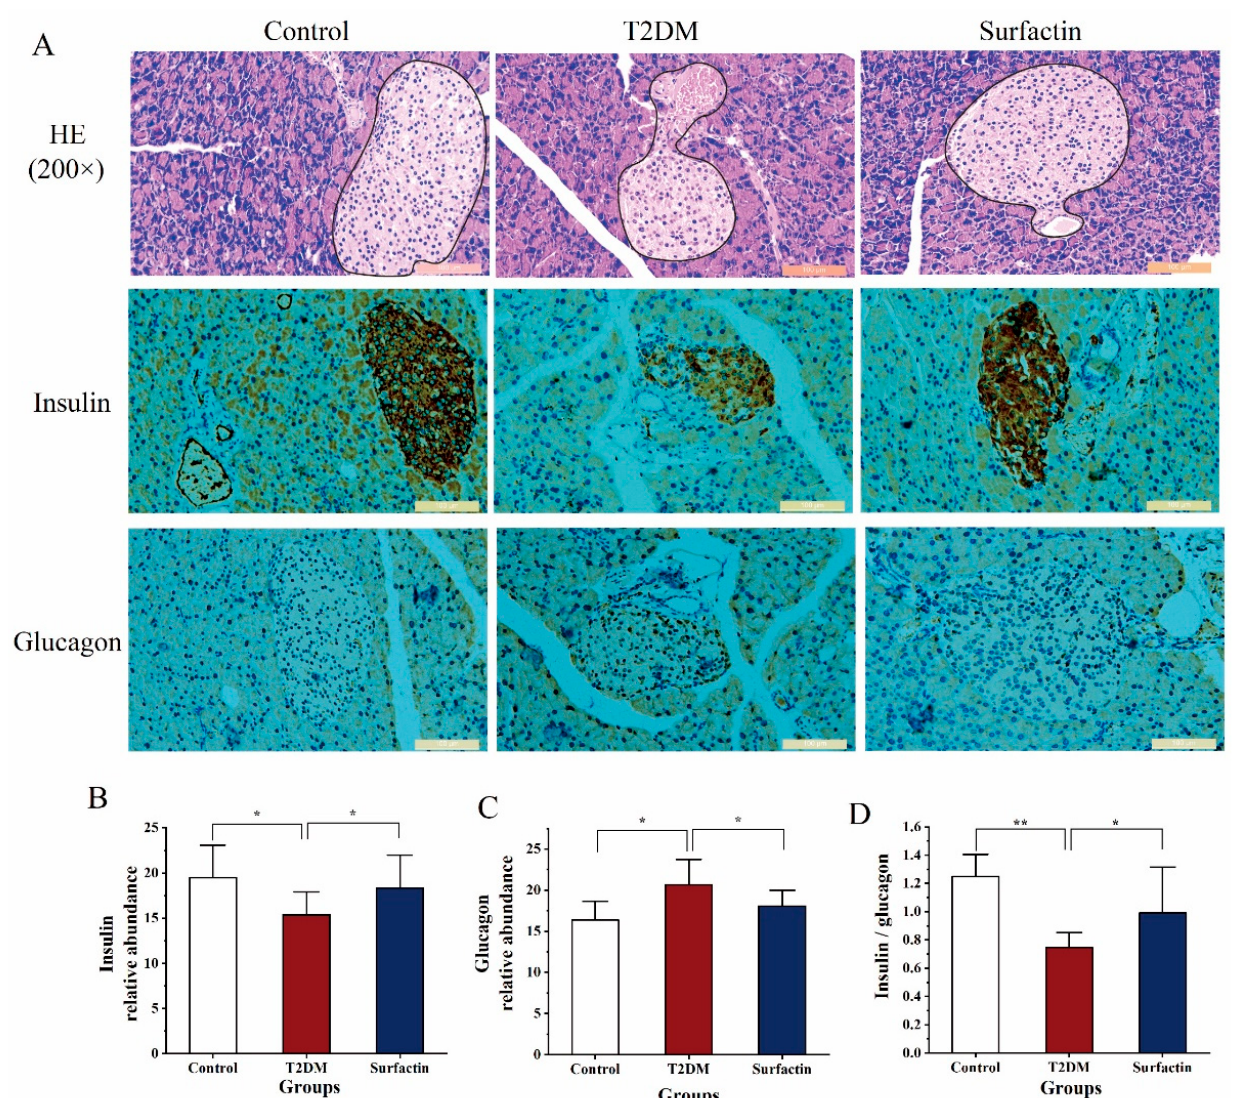
Figure 3. Effects of surfactin on pancreas tissue and function in HFD/STZ-induced T2DM mice. The control group represents normal mice fed a basic diet, the T2DM group represents mice with T2DM induced by a 60% fat diet and 30 mg/kg body weight STZ, and the surfactin group represents T2DM mice treated with 80 mg/kg body weight surfactin. H&E staining of the pancreas and immunohistochemistry for insulin and glucagon ( A ), the corresponding relative abundance of insulin ( B ), the corresponding relative abundance of glucagon ( C ) and the ratio of insulin to glucagon ( D ). * indicates significant differences at p < 0.05, ** indicates significant differences at p < 0.01. 2.3. Effects of Surfactin on Proteins Associated with Glycometabolism of the Pancreas in T2DM Mice In the present study, PI3K protein levels in T2DM mice were significantly higher than the control mice, while surfactin significantly downregulated this protein expression compared with the T2DM mice (Figure 4A), and the trend is similar to the normal mice. After surfactin treatment, the protein levels of p-PI3K and the ratio of p-PI3K to PI3K were noticeably increased compared to that in the T2DM mice (Figure 4B,C). T2DM mice had much lower levels of the protein Akt than the control mice, whereas T2DM mice treated with surfactin had significantly higher levels of Akt than the T2DM mice (Figure 4D). In comparison to the T2DM mice, surfactin also noticeably increased the protein levels of p-Akt (Figure 4E). Conversely, the ratio of p-Akt to Akt was highly increased in T2DM mice compared to the control mice, but it was significantly downregulated in T2DM